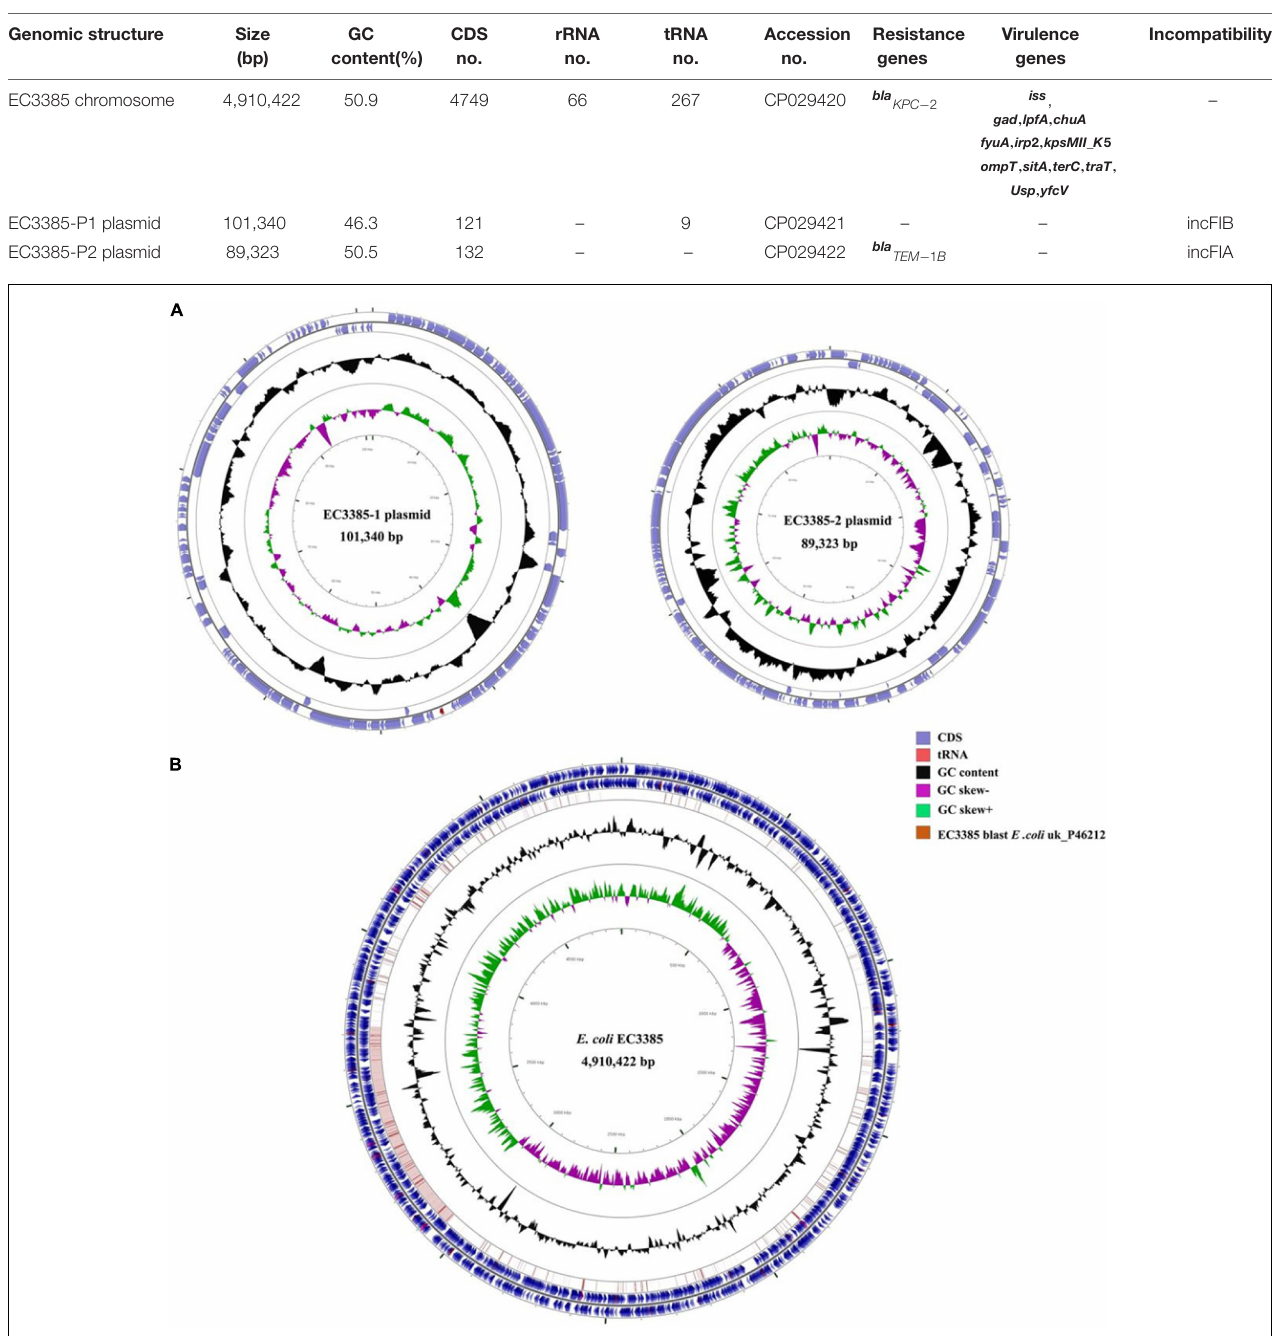
TABLE 2 | Genome and plasmids of E. coli EC3385.